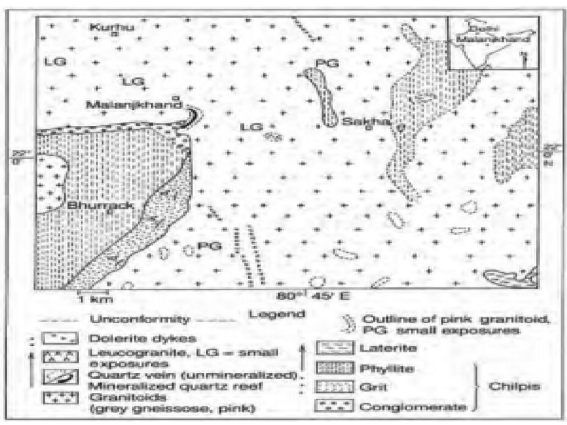
Figure 1. Geological map of the Malanjkhand copper deposit 40